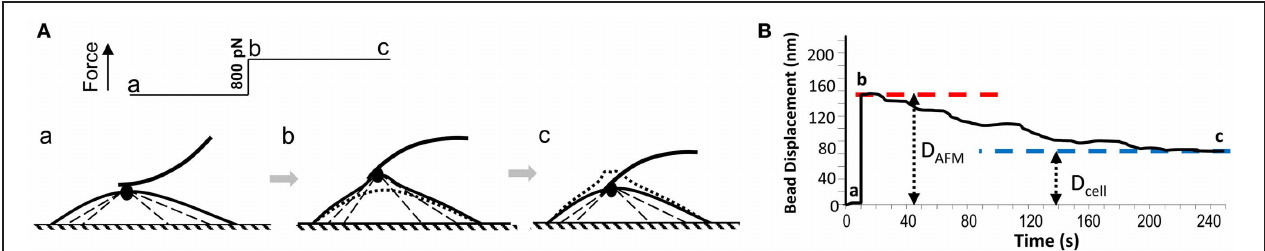
FIGURE 1 | (A) A schematic illustration of AFM pulling experiment on VSMC cell: a, AFM cantilever probe with a FN-coated bead at the tip forms focal adhesion on VSMC surface; b, AFM pulling force (800pN) was applied to FN-focal adhesion by altering the cantilever deflection, and lifted the FN-bead and focal adhesion; c, while AFM pulling force